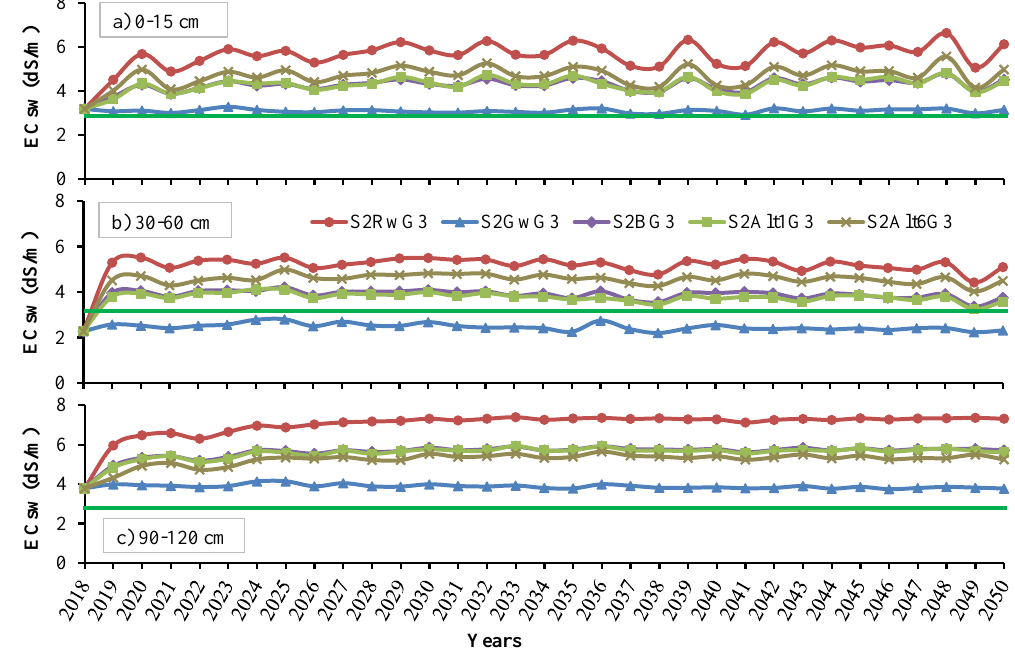
Figure 9. Impact of different water qualities (recycled water, RW; good water, GW; blending of RW and GW in a 1:1 ratio, B; RW and GW used in monthly cycles, Alt1; and RW and GW used half-yearly cycles, Alt6) and annual gypsum applications of 8.6 t/ha (G3) on EC sw for hard red-brown soil (S2) under almond cultivation.